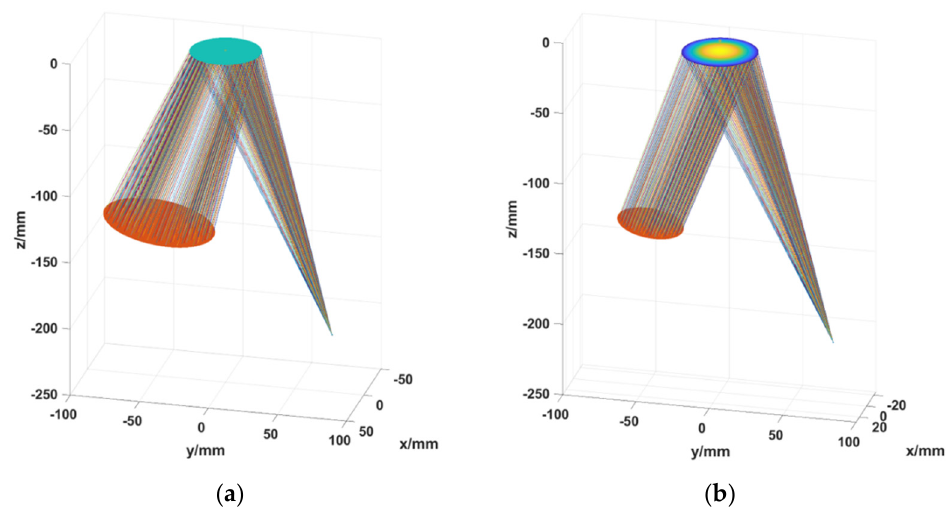
Figure 3. The simulation model of the SMPMD system. ( a ) The monoscopic deflectometric simulation model of the planar mirror. ( b ) The monoscopic deflectometric simulation model of the concave mirror. The configuration of the measuring system is the same as that of the planar mirror.